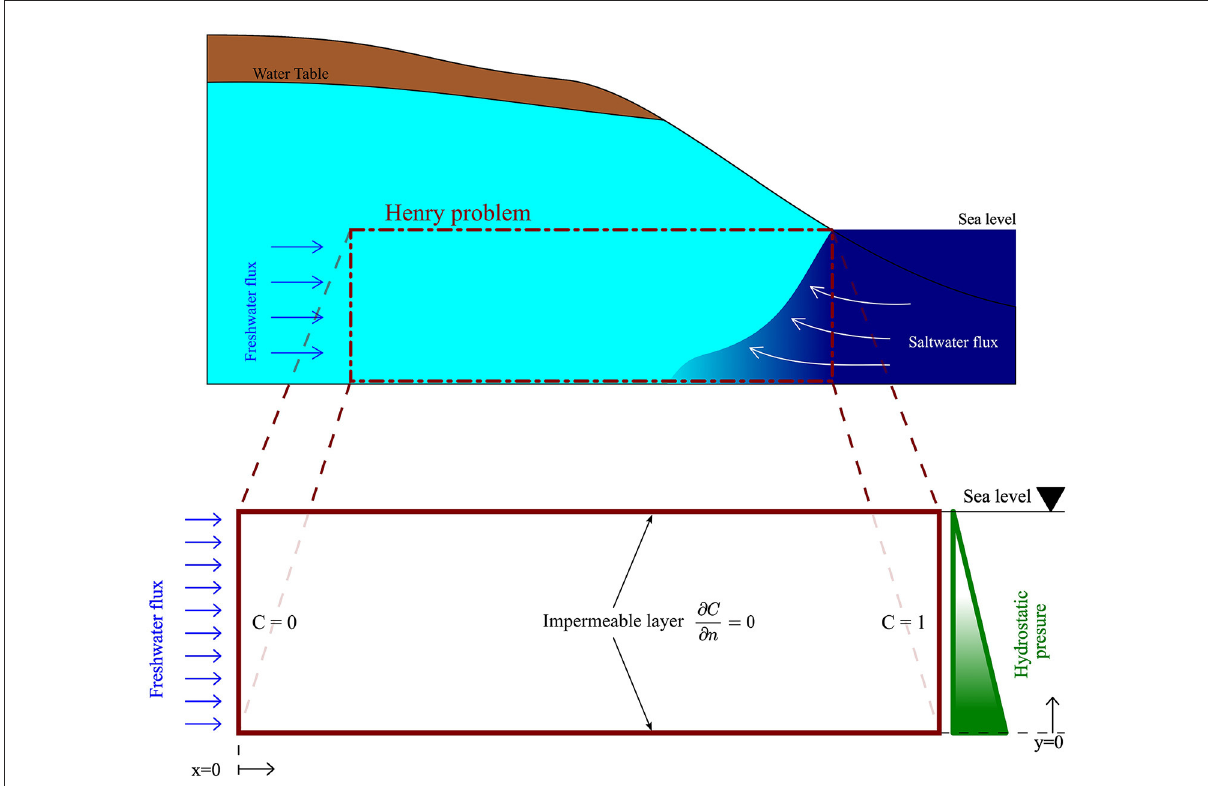
FIGURE1 Henry problem computational